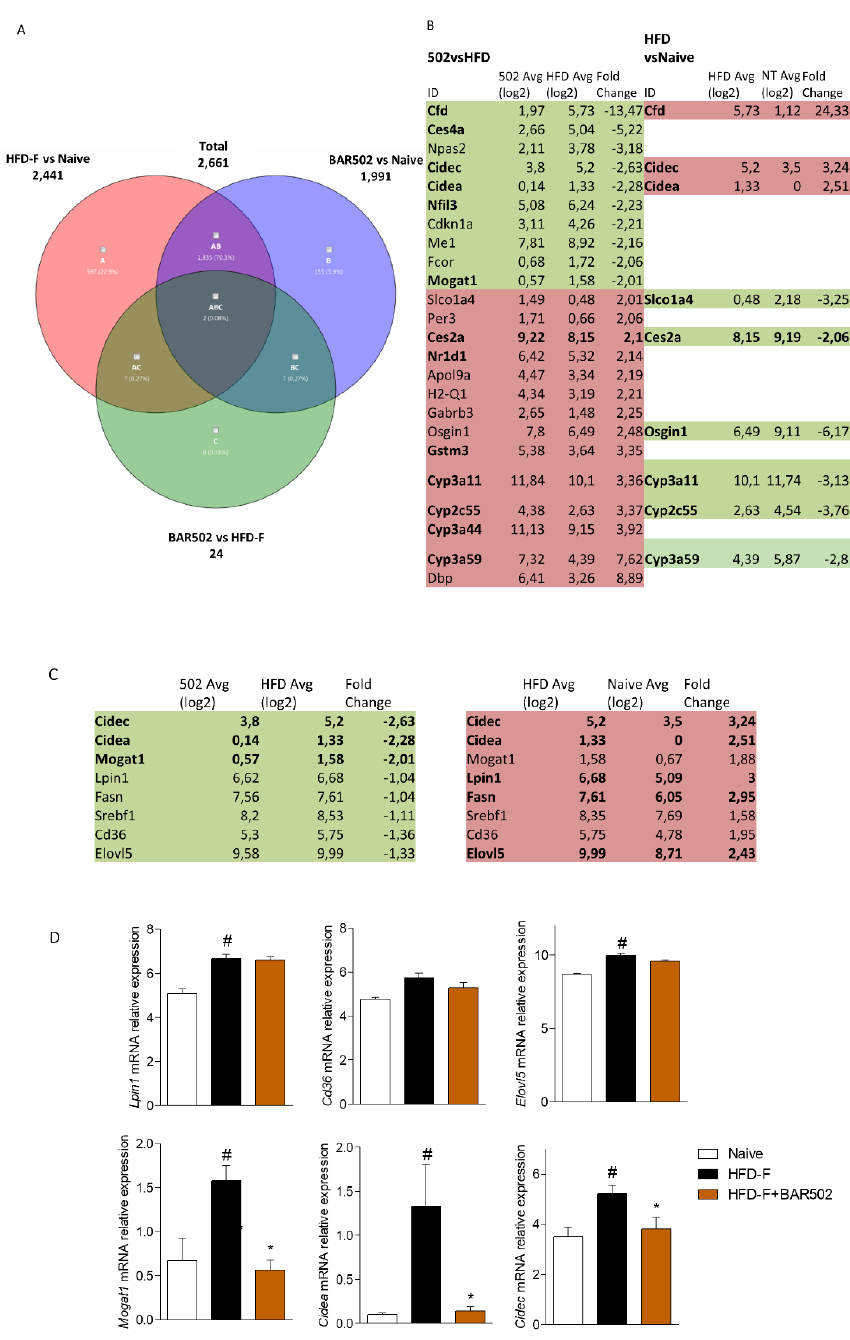
Figure 4. RNA-seq of BAR502 treated mice. BAR502, 20 mg/kg/day, was administered by gavage in C57BL/6J male mice starting on day 10 of high fat diet (HFD) and fructose for an additional 11 weeks. ( A ) Venn diagram of differentially expressed genes showing the overlapping regions (identified as ABC, AC, AB, and BC sets) between the three experimental groups of mice (Fold Change < − 2 or >2, p value <0.05). ( B ) Table showing the fold change of expression of genes included in region C, AC, and ABC of the corresponding Venn Diagram. Panel C – D. Analysis of genes involved in triglycerides synthesis and lipid storage into the hepatocytes, that were found differentially expressed both in HFD – F mice compared to Naïve mice, both in HFD – F + BAR502 and HFD – F + UDCA compared to HFD – F mice. In each panel # denotes p < 0.05 versus Naïve mice, * denotes p < 0.05 versus HFD – F mice.